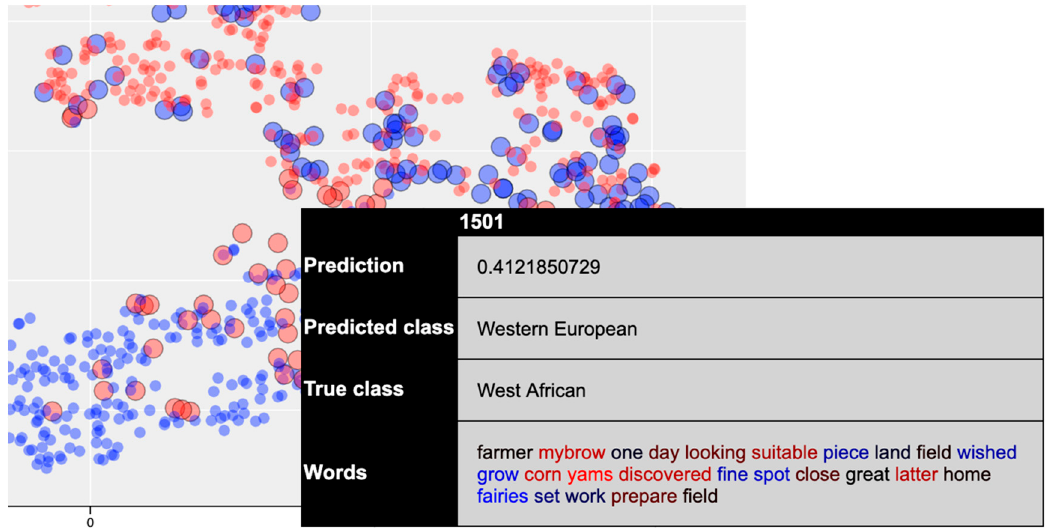
Figure 5. t-SNE table of a larger data point that indicates a discrepancy between the predicted class and true class. The table shows the prediction value and a color indication of the classified geographical background for each of the words according to class